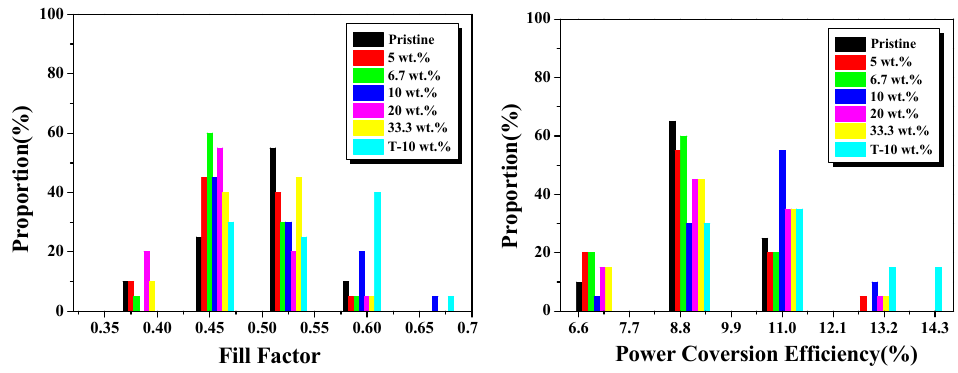
Figure 5. Statistic device performance parameters of Voc, Jsc, FF and power conversion efficiency (PCE) for solar cells with various Ag NPs concentrations.